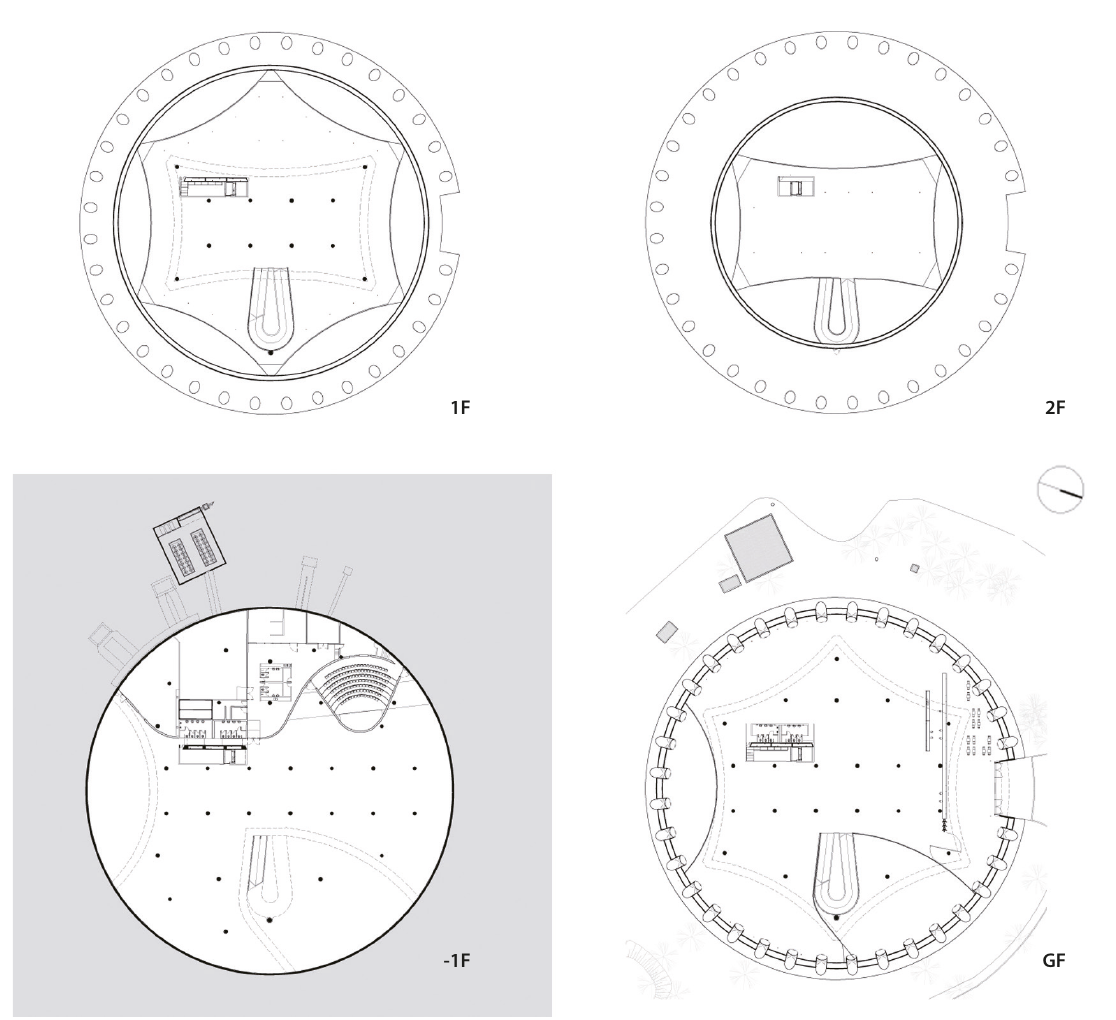
-1F1F GF2F Figure 5b SPBR Arquitetos, 1999 reform plans of Palace of Arts (Oca) (Source: SPBR).